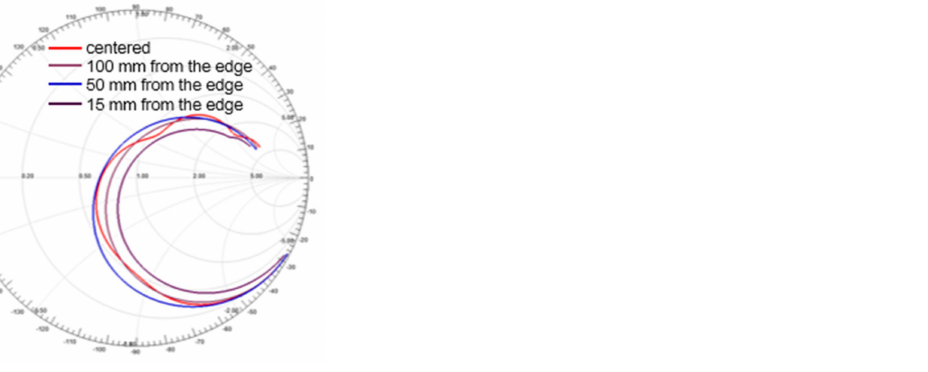
Figure 5. Comparison of normalized impedance between centered and off-centered mounting configurations.